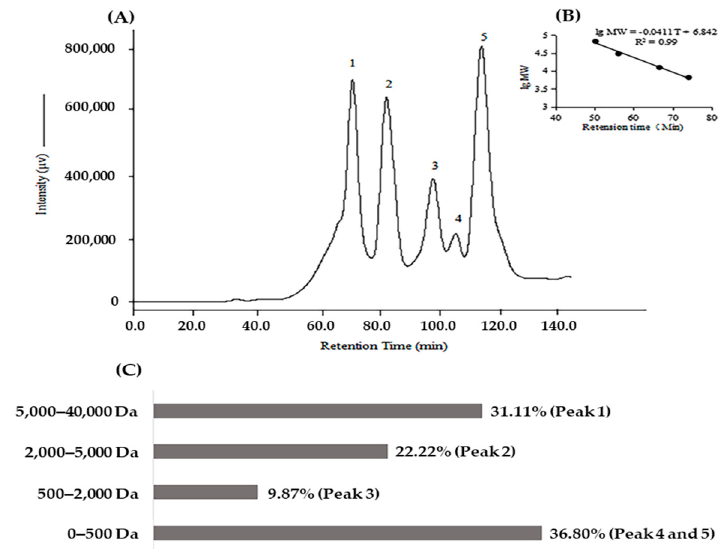
Figure 1. Size–exclusion chromatogram on a Superdex 75 10/300 GL column of KSHPH ( A ) and the calibration curve ( B ). Molecular weight distribution of KSHPH was calculated by calibration curve ( C ).